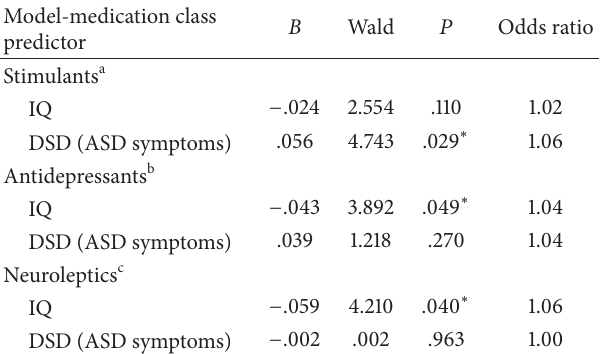
Table 2: Logistic regression results for the odds of taking a specific psychotropic medication